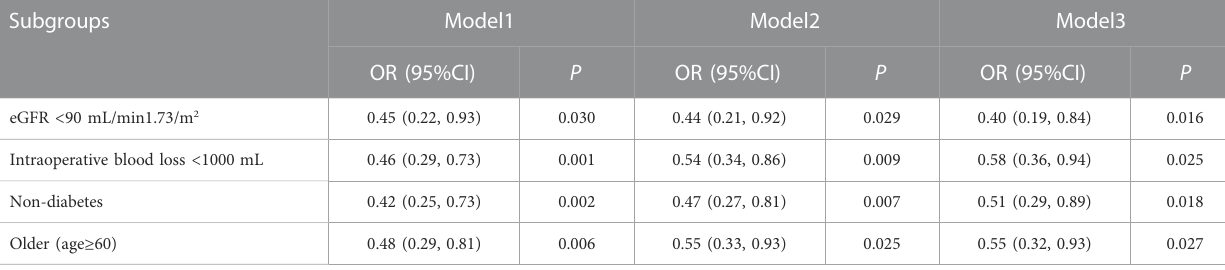
TABLE 4 Sensitivity analysis of the association between postoperative AKI and perioperative dexmedetomidine administration in four subgroups.